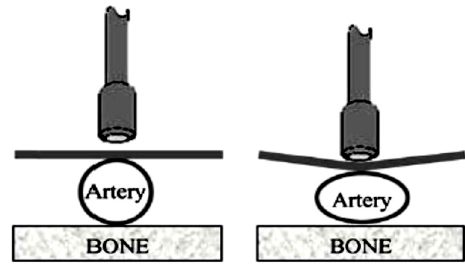
Figure 2. Schematic of using a tonometer probe [11].